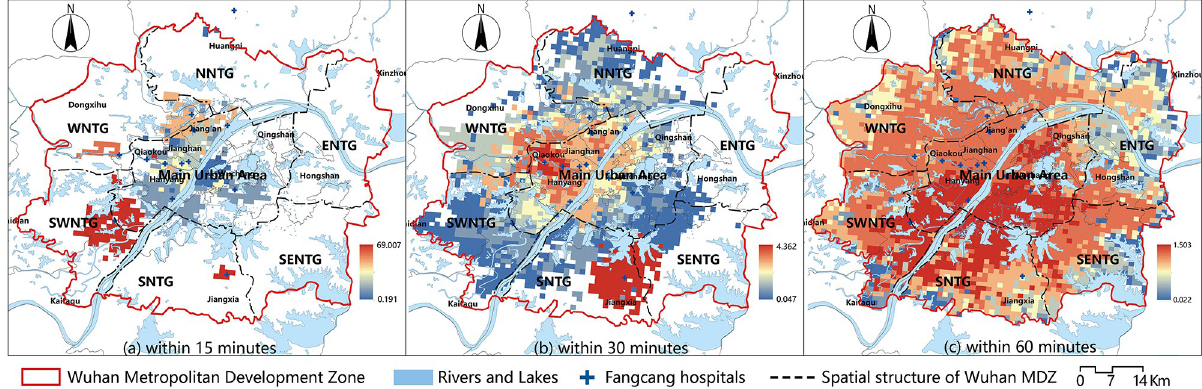
Fig 7. Accessibility of Fangcang hospitals. (a)Within 15 minutes, (b) Within 30 minutes, (c) Within 60 minutes.